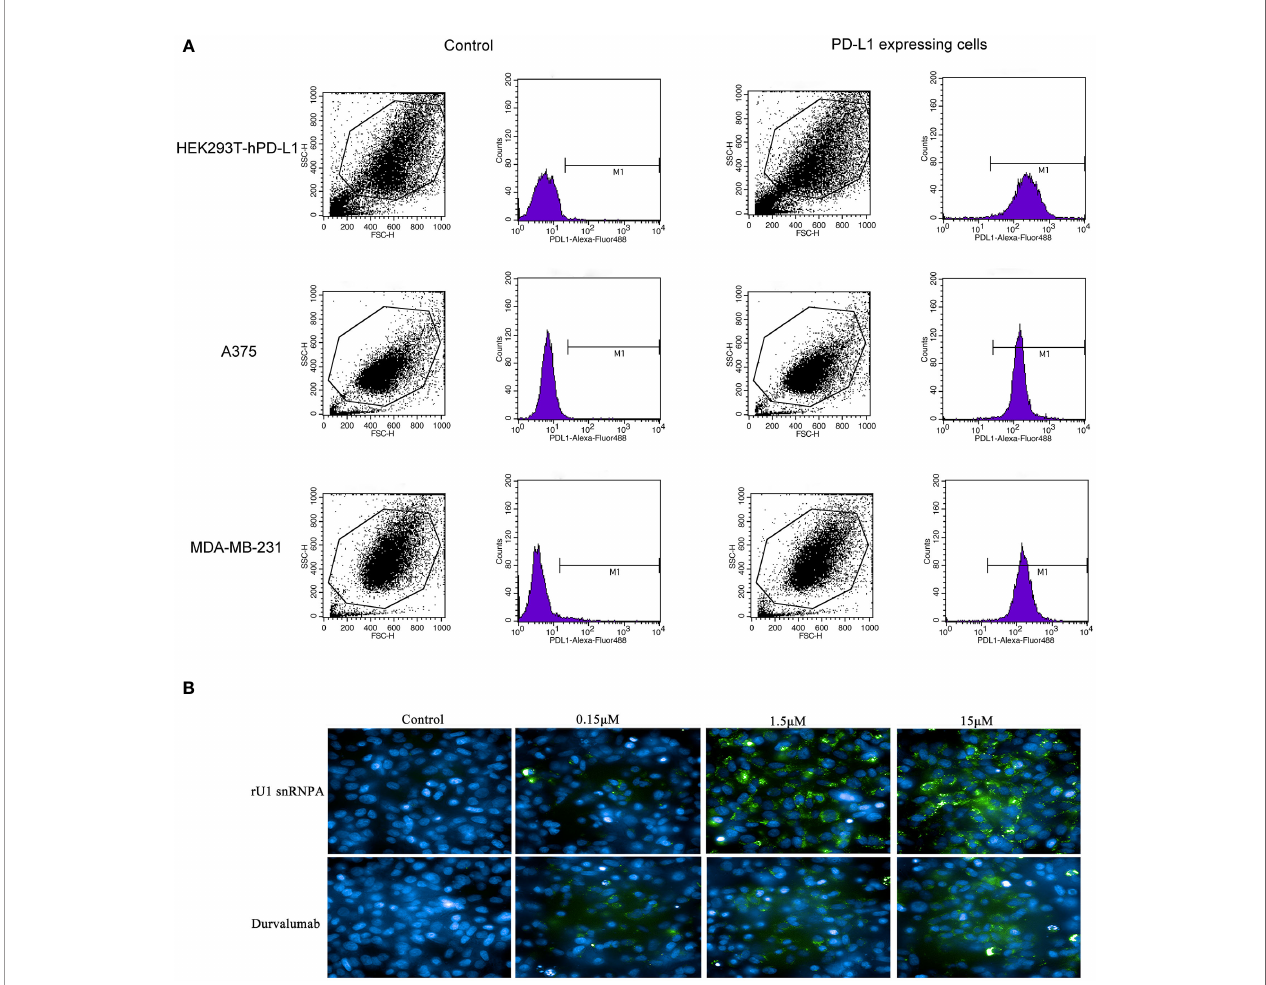
FIGURE 3 | (A) Flow cytometry results of the expression of hPD-L1 on cells. (B) High content imaging of A375 cells with different concentrations of rU1 snRNPA or durvalumab. Blue, nucleus by Hoechst33342; green, rU1 snRNPA or durvalumab conjugated with Alexa Fluor ® 488 NHS